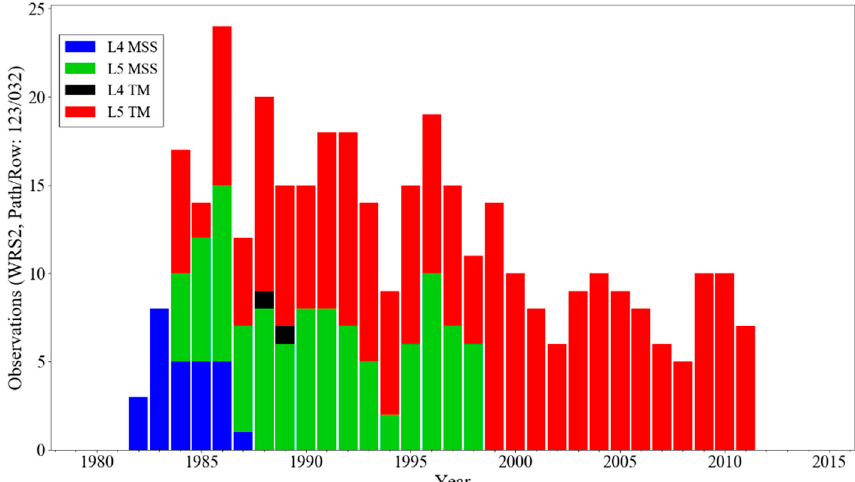
Figure 2. Temporal distribution of the valid Landsat 4-5 MSS and TM scenes over the Worldwide Reference System (WRS)-2 Path/Row 123/032, in the Landsat Collection 1 Level-1 data product (https://earthexplorer.usgs.gov/). The valid scene was manually selected in terms of cloud cover and imagery quality through visual discrimination.